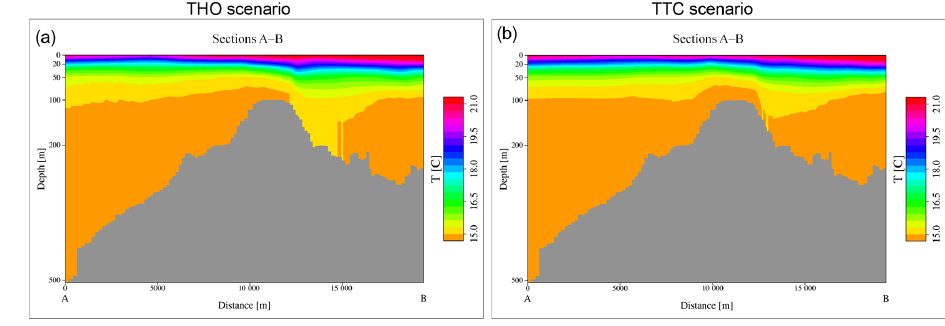
Figure 9. Summer average water temperature along sections A–B computed from THO and TTC scenarios ( b and d ).